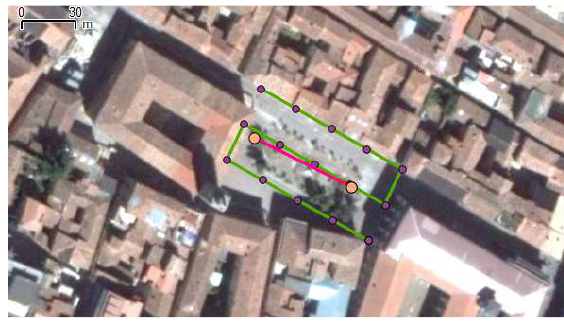
Figure 2. Vector files loaded into the open source software QGIS